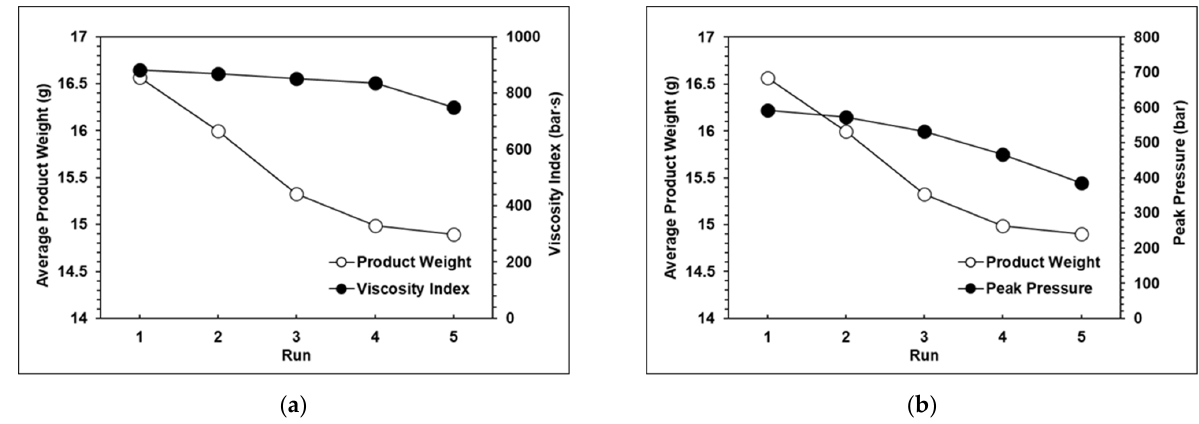
Figure 10. ( a ) Relationship between the product weight and the viscosity index with 20 tons of clamping force; ( b ) Relationship between the product weight and the peak pressure with 20 tons of clamping force.